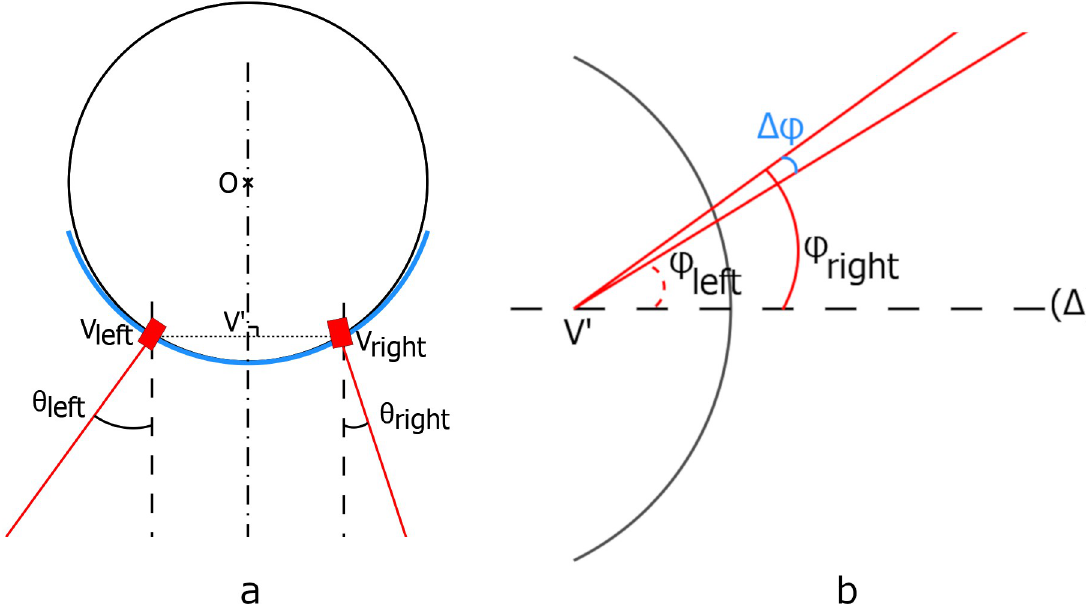
Fig 2. (a) CLP top view with the horizontal angular separation; (b) Side view with the vertical angular